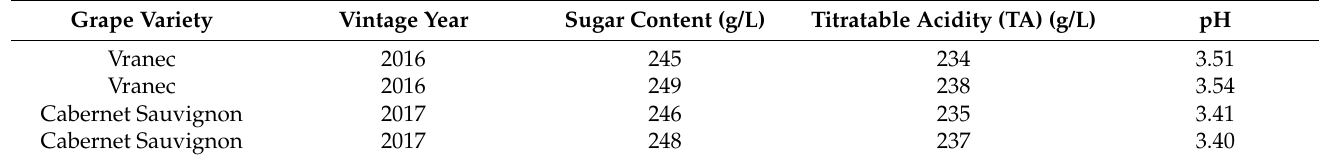
Table 2. Sugar content, titratable acidity, and pH values of grapes from Vranec and Cabernet Sauvignon for vintage years 2016 and